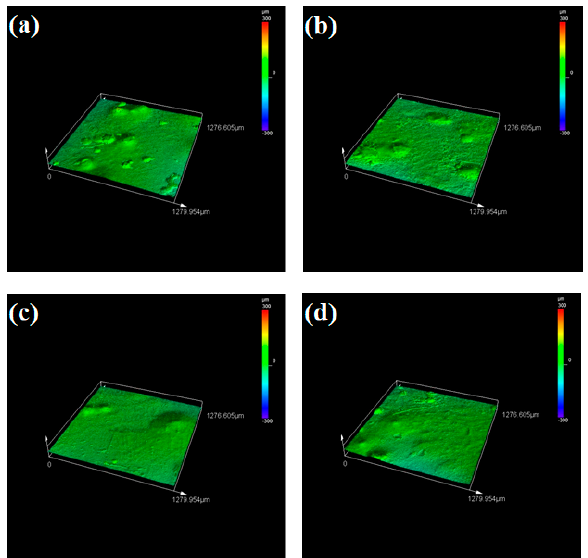
Figure 11. 3D surface plots obtained using the laser microscope after the corrosion test for the substrate samples at ( a ) 0 h, ( b ) 18 h, ( c ) 42 h and ( d ) 70 h.